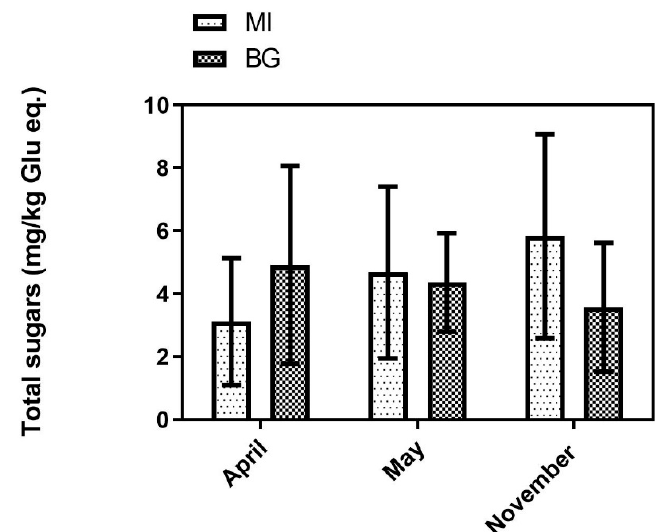
MI in November, to 3.1 mg Glu eq./g FW in the April (Figure 3).